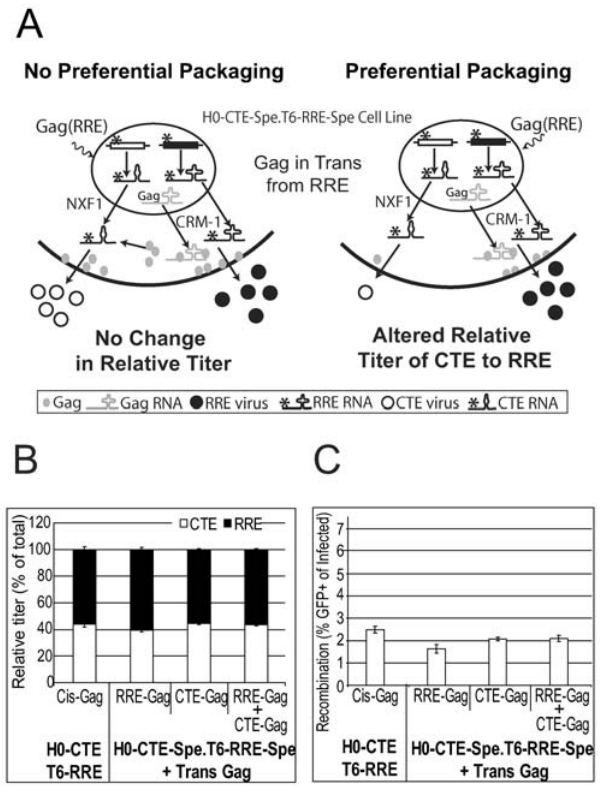
Figure 5. Effect of nuclear export pathway used by gag mRNA on genomic RNA packaging and recombination. (A) Schematic representations of the expected outcomes when Gag is provided in trans by mRNA using the CRM-1 pathway. (B) Proportion of the two viruses released from the H0-CTE-Spe.T6-RRE-Spe cell line when Gag is provided in trans by mRNA using either the CRM-1 or NXF1 pathway, or both. The virus proportions when Gag is provided in cis are also shown for comparison. (C) The recombination rate between the two viruses when Gag is provided in trans. Means and standard deviation generated from three experiments are